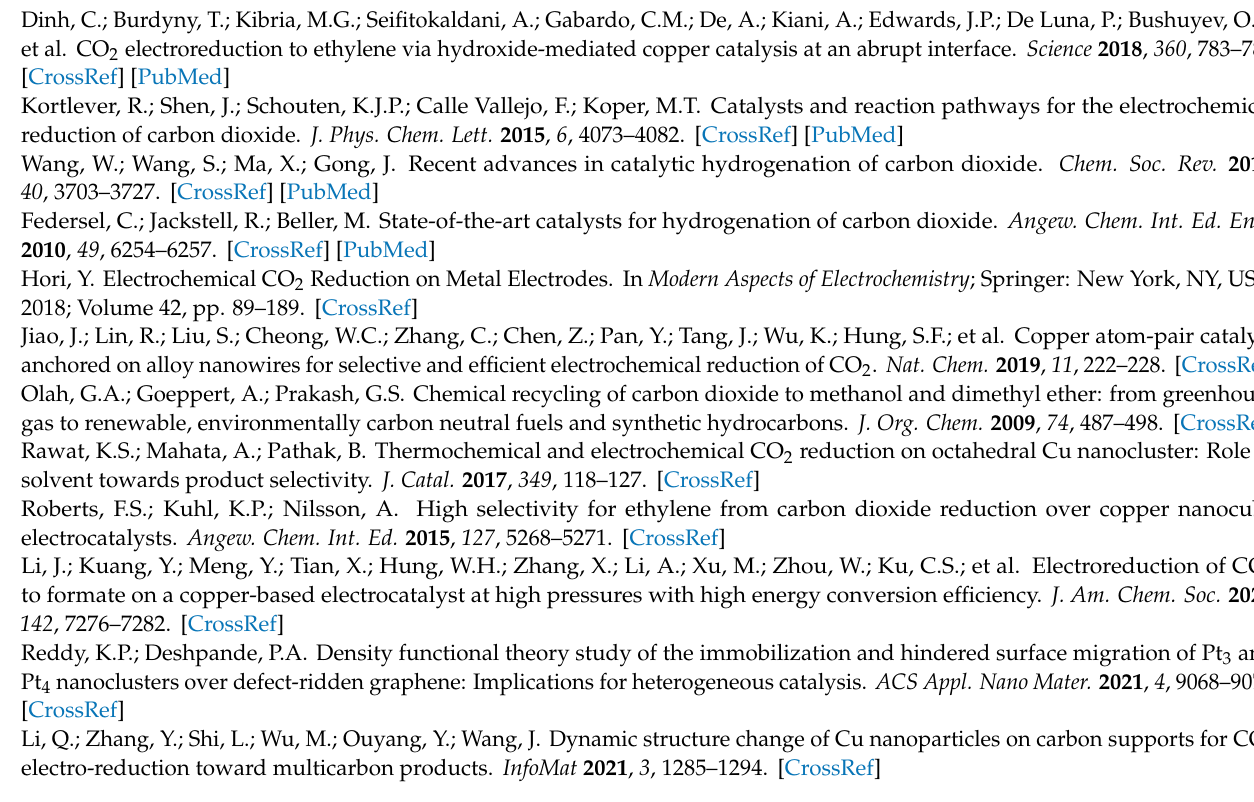
Mechanistic free energies diagram of electrochemical CO 2 reduction on Cu 4 O 2 cluster, Cu 4 S 2 cluster, and Cu 4 Se 2 cluster with no applied potential; Figure S4: Free energies diagram for producing H 2 , CO, and HCOOH with no applied potential; Figure S5: Kinetic barrier diagram of product-determining step on Cu 4 O 2 cluster, Cu 4 S 2 cluster, and Cu 4 Se 2 cluster; Figure S6: Mechanistic free energies diagram of electrochemical CO 2 reduction on the Cu 4 O 4 cluster, Cu 4 S 4 cluster, and Cu 4 Se 4 cluster with no applied potential; Figure S7: Total density of states (DOS) of Cu 4 S 2/ SV catalyst, Projected density of states (PDOS) of p orbitals of C, and PDOS of d orbitals of Cu; Figure S8: Variation the reaction free energy of COOH * on Cu 4 S 2/ SV catalyst as a function of the cutoff energy value in the plane-wave calculations; Table S1: Geometric parameters , the maximum, and minimum harmonic vibrational frequencies of the GM structure of gas-phase Cu 4 X 2 clusters; Table S2: The charge distribution of elements in the neutral Cu 4 X, Cu 4 X 2 , and Cu 4 X 4 clusters by the natural bond orbital charge analysis; Table S3: The charge distribution of elements in the neutral Cu 4 X, Cu 4 X 2 , and Cu 4 X 4 clusters with electrochemical CO 2 adsorption by the natural bond orbital charge